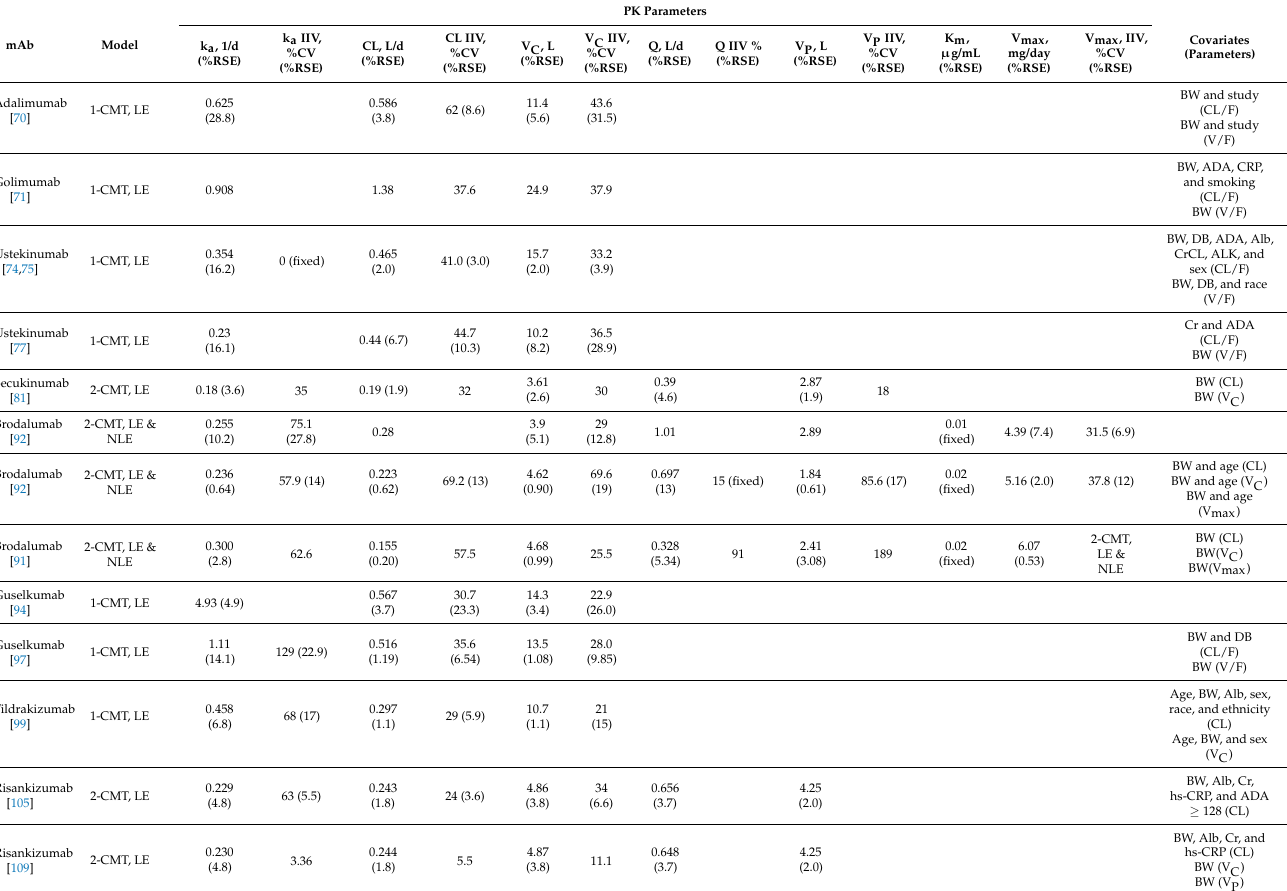
Table 3. Population pharmacokinetic parameters of monoclonal antibodies in